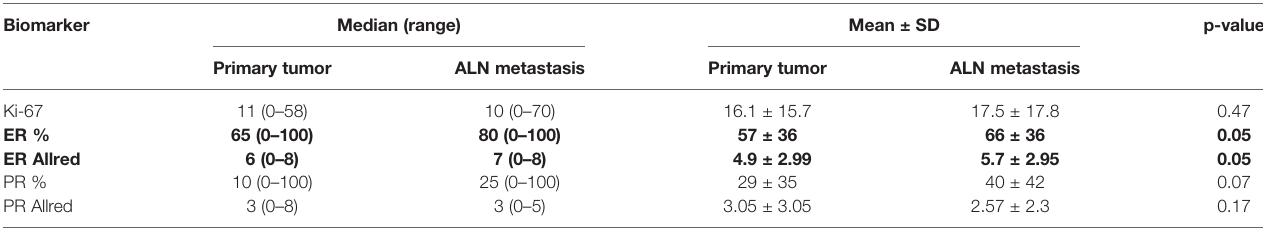
TABLE 4 | The numerical summary of numerical variables such as Ki-67 index of positive cell nuclei, ER, as well as PR index of positive cell nuclei and Allred score compared with paired Wilcoxon signed rank test. Biomarker